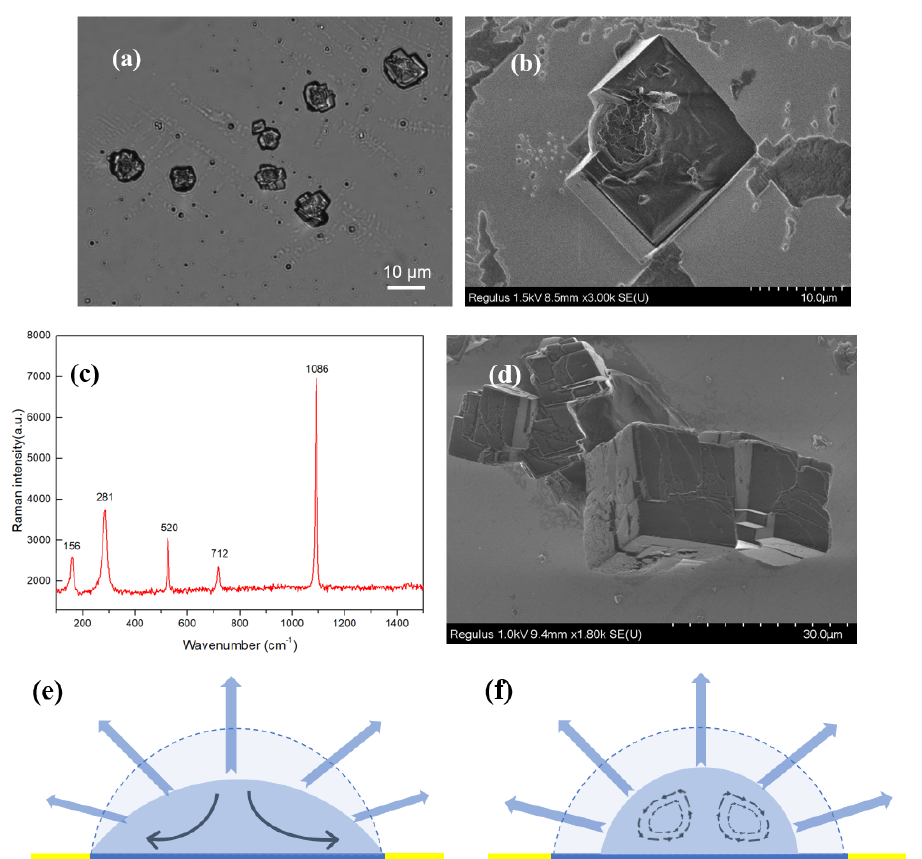
Figure 4. ( a ) Optical micrograph of CaCO 3 crystals formed in droplets; ( b ) Scanning electron microscopy (SEM) image of one crystal formed on a 400 µ m diameter droplet. ( c ) Representative Raman